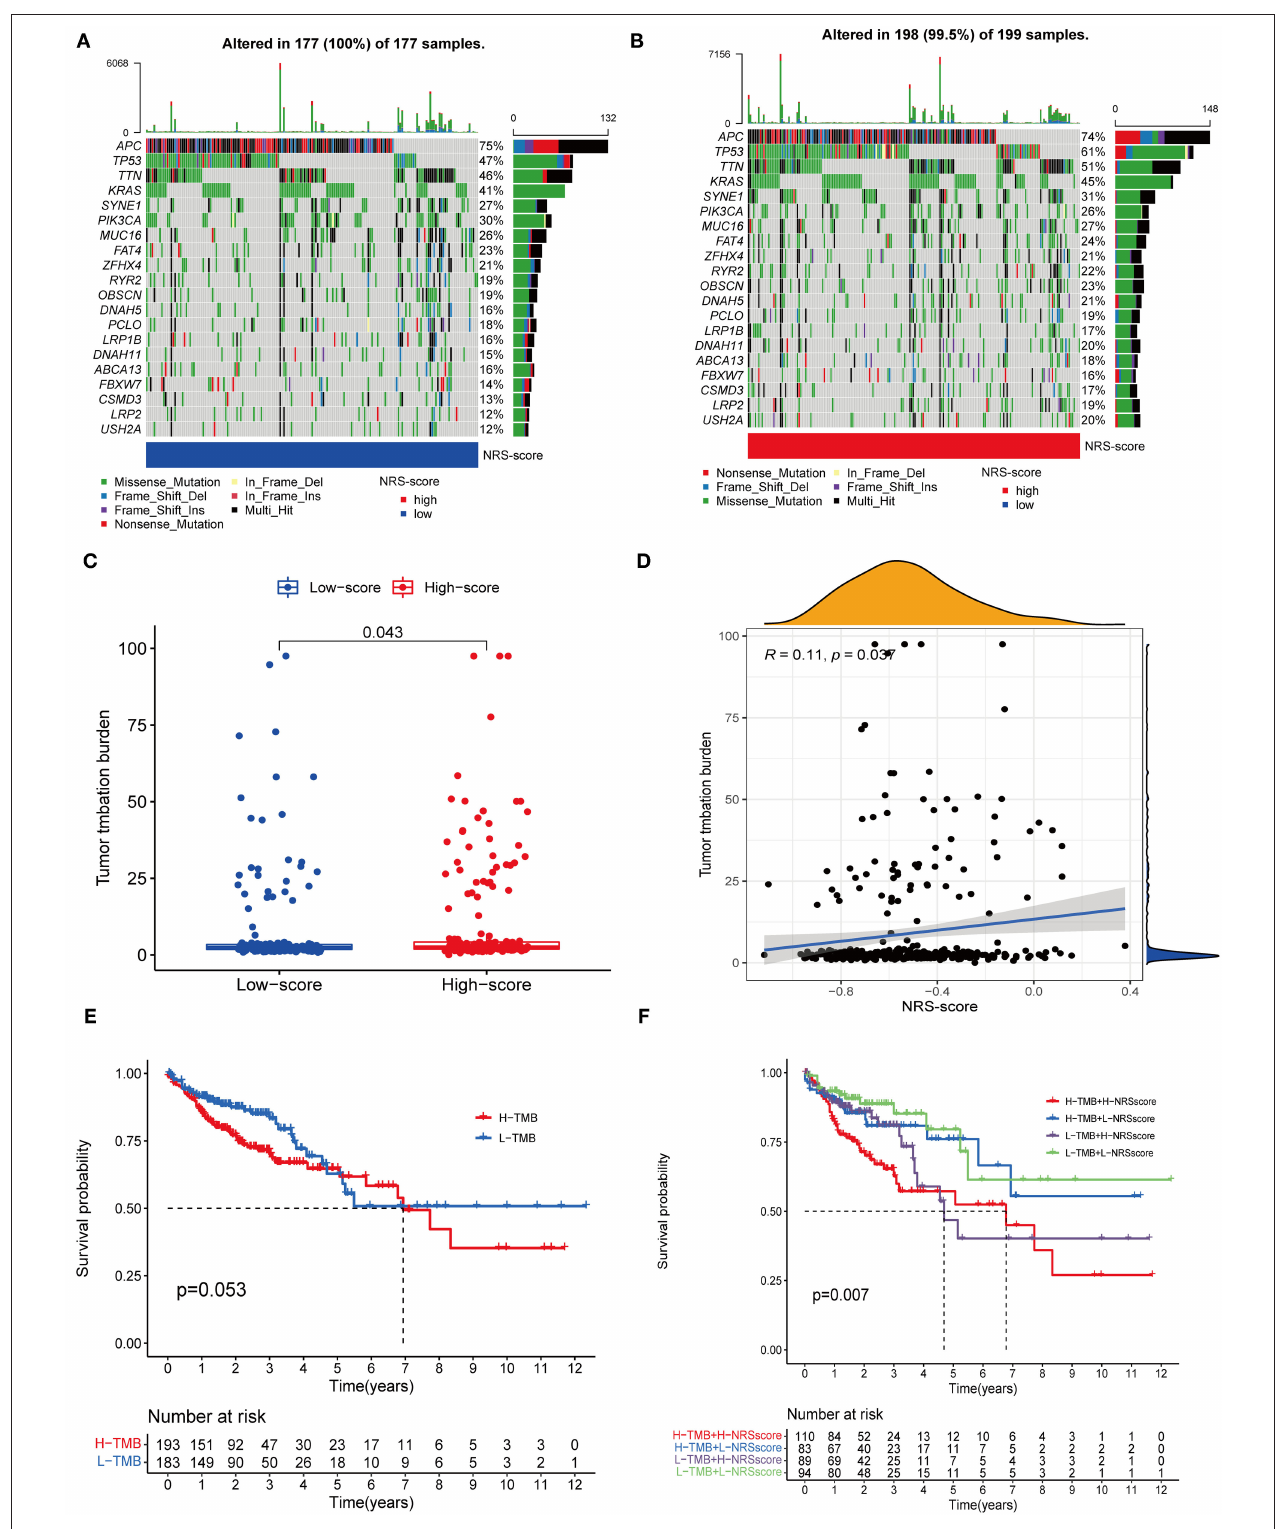
FIGURE 9 | Correlation between NRS-score and somatic mutations. (A,B) Waterfall plots showed the top 20 frequently mutated genes in the (A) low NRS-score and (B) high NRS-score groups in the TCGA cohort. (C) TMB differences between the high NRS-score and low NRS-score groups. (D) The scatter plot depicted a positive correlation between NRS-score and TMB. (E) Kaplan-Meier curves for the high TMB and low TMB groups in the TCGA cohort. (F) Kaplan-Meier curves for patients stratified by NRS-score and TMB in the TCGA cohort.